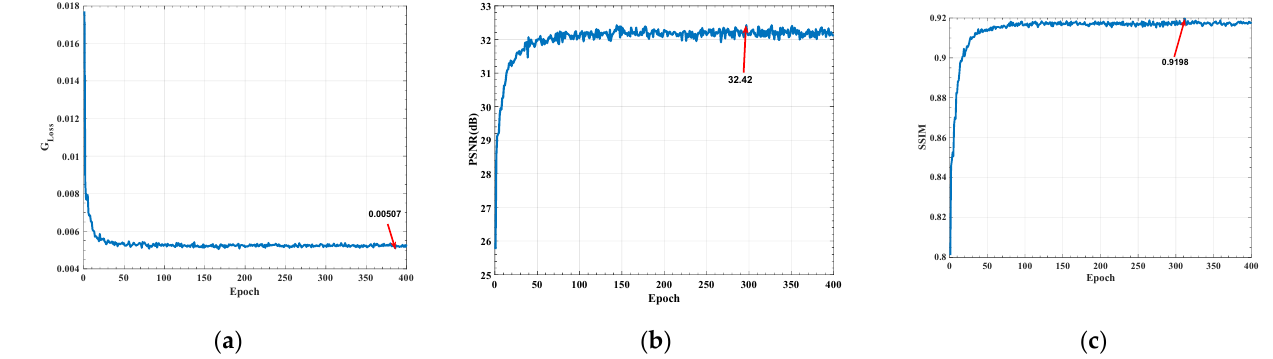
Figure 13. SRGAN training results: ( a ) Generator loss; ( b ) Peak signal-to-noise ratio; ( c ) Structural similarity index measurement.